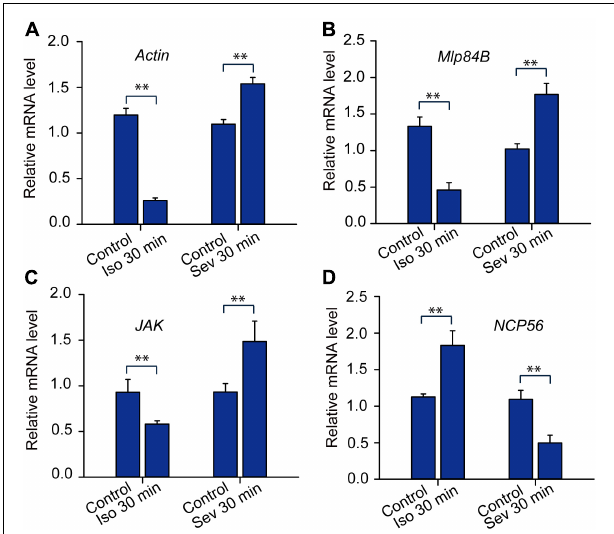
FIGURE 5 | The expression profiles of the transcripts expressed differentially in responding to isoflurane (1.2%) and sevoflurane (3.2%) anesthesia. The expression levels of Actin ( A, n = 6), Mlp84B ( B, n = 6), JAK ( C, n = 6) and NCP56 ( D , n = 6) in brains of the migratory locusts in responding to 30 min of isoflurane and sevoflurane, respectively. Student’s t -test is used for analyzing gene expression levels underlying anesthesia. The expression levels of those genes are shown as the mean ± SEM. ∗∗ P < 0.01. Mlp84B, Myosin-like protein 84B; NCP56, nymph cuticle protein 56; JAK, Janus kinase; Iso,